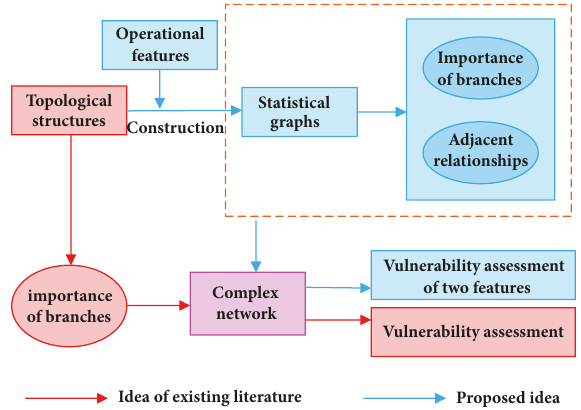
Figure 1: Comparison between proposed idea and existing litera- tures based on